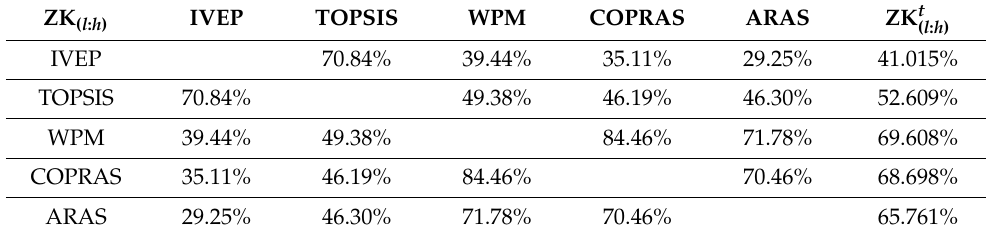
Table 7. The analytical comparison of the similarities of the performance of each MCDM